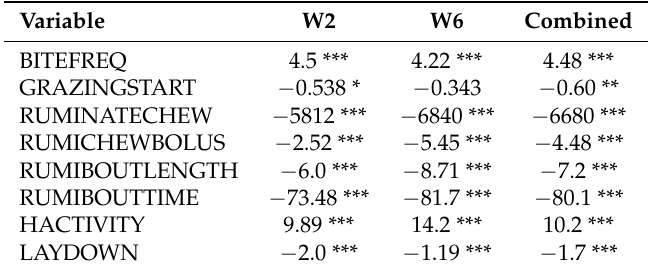
Table A2. Independent samples t -tests for significant differences of means of each predictor in the 100% and 60% herbage allowance groups using W2, W6 and combined